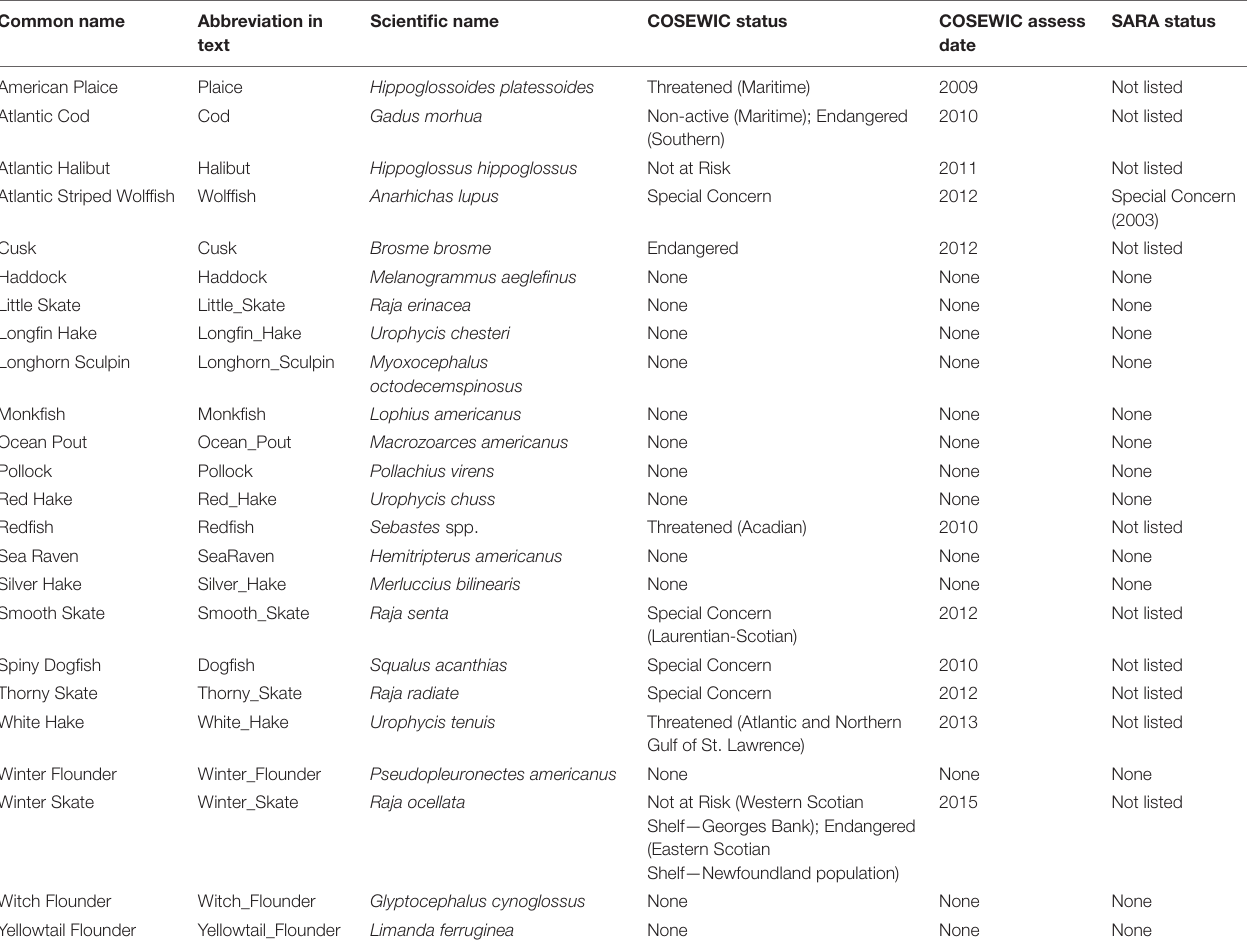
TABLE 1 | Twenty-four common groundfish species and their conservation